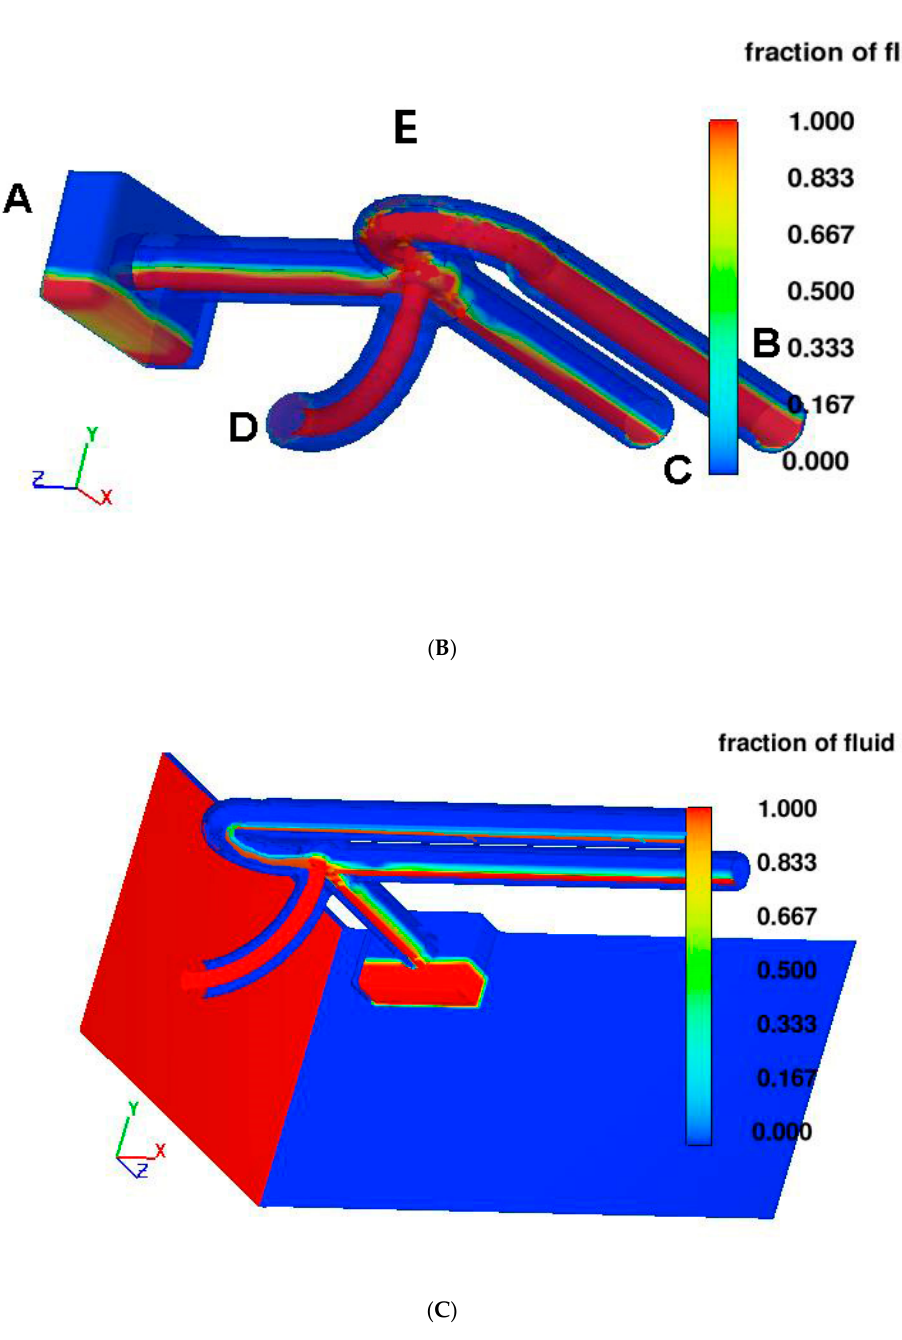
Figure 21. FLOW-3D CFD model of the pipeline connections constructed from Figure 20 components and downhill exposed pipeline elements. ( A ) Incipient filling of pit basin A due to hydraulic jump instability (or an E – B, E — C blockage) causing transient back flow conditions that are damped by water flow into the A pit basin. ( B ) Partial filling of pit basin A after pipeline instabilities are damped; note partial flow in high slope pipelines E – B and E – C . ( C ) Alternate view of Figure 21 B conditions.